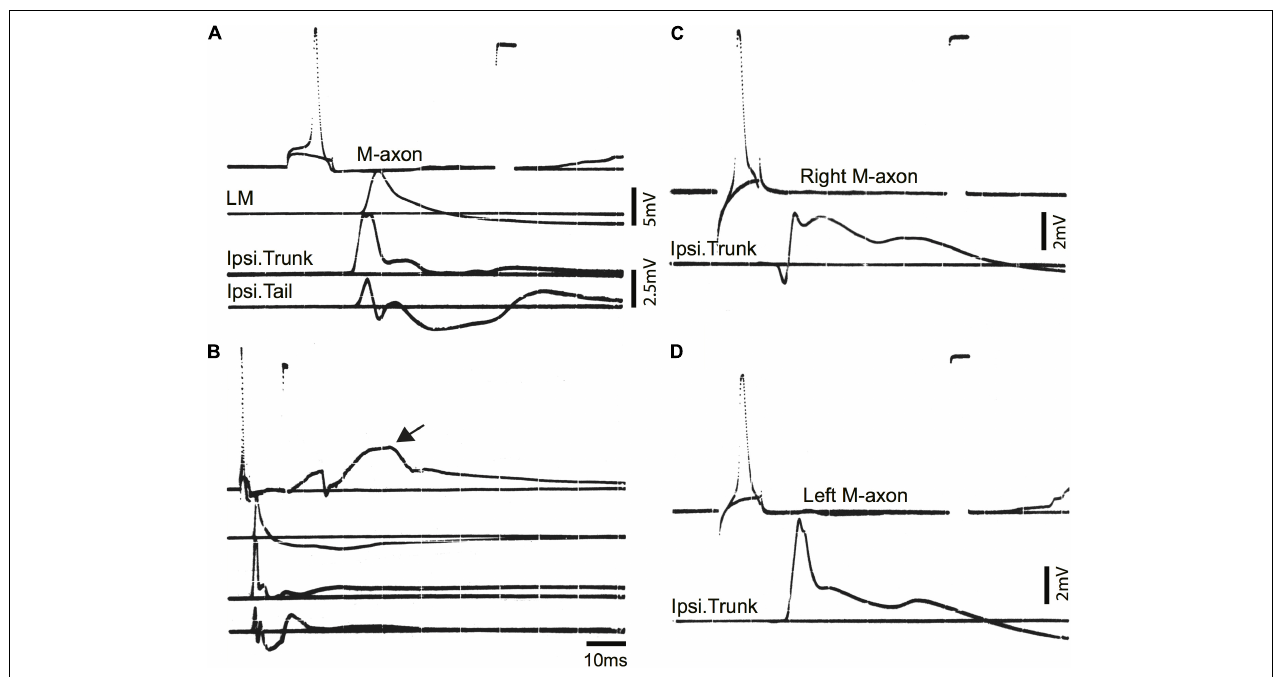
FIGURE 5 | Mauthner-axon activation and EMG responses in control fish. (A) Intracellular activation of the M-axon results in EMG responses of head, trunk, and tail musculature. Traces from top to bottom: (1) Intracellular recording from the M-axon above and below threshold. Unless stated otherwise, calibration pulse is 80 mV and 1 ms in this and subsequent figures, (2) EMG recording from the left mandibular muscle (LM), (3) recording of trunk musculature ipsilateral to the M-axon (Ipsi. Trunk), and (4) EMG recording from the tail musculature ipsilateral to the M-axon (Ipsi. Tail). (B) Recording, as in panel (A) , but at a longer time base to show the time course of EMG responses. The arrow designates the shift in resting potential due to movement of the fish. (C,D) Activation of the right (C) and left (D) M-axons in a control fish, held for 422 days in captivity. The top trace is from the M-axon above and below threshold and the bottom trace is an EMG recording from trunk musculature ipsilateral to the